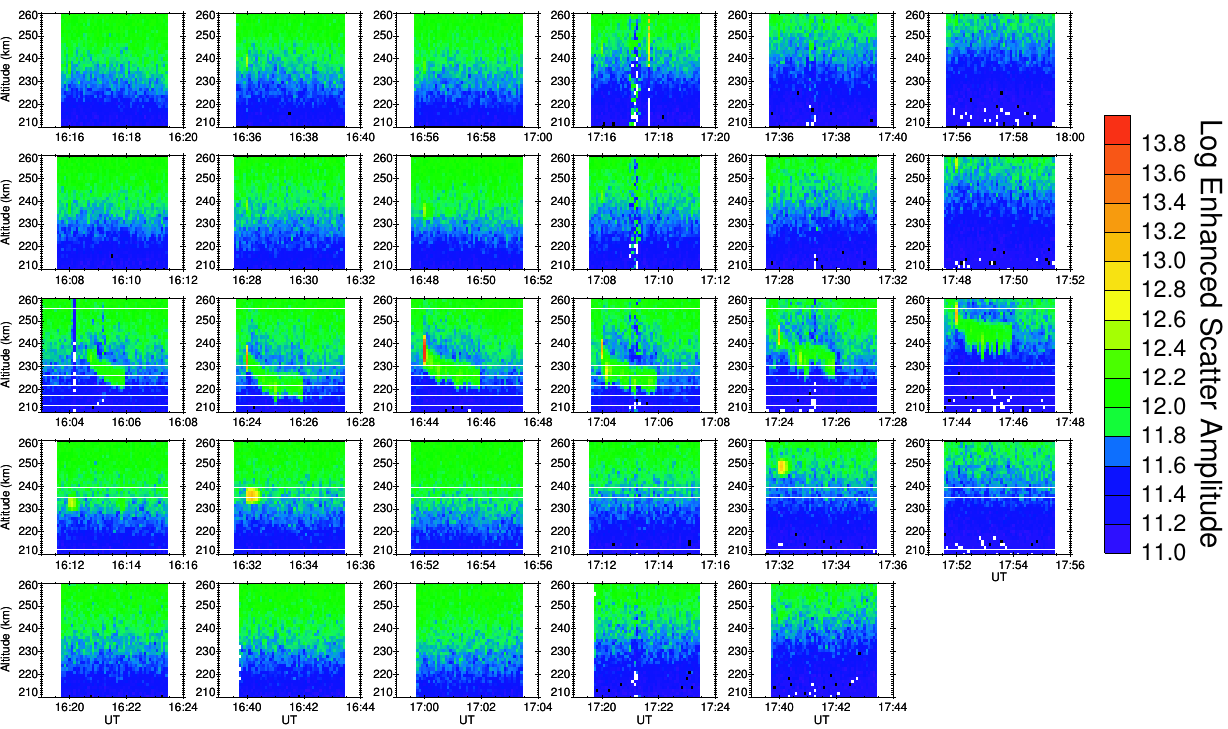
Fig. 2. Backscatter amplitudes for 16:00–18:00 UT on 25 September 2002 for FA heater pointing. The five rows correspond to the five UHF pointing directions: FA+12, FA+6, FA, FA − 6 and FA − 12. The altitude versus the time is shown and the colours give the backscatter intensity. The backscatter enhancement at heater switch-on may be seen in FA+12, FA+6 and FA, together with a more complex signature in FA − 6. For FA UHF pointing, there is a descending signature with backscatter amplitudes that are lower than those at heater switch-on. The descent stabilizes and is present for the entire heater-on